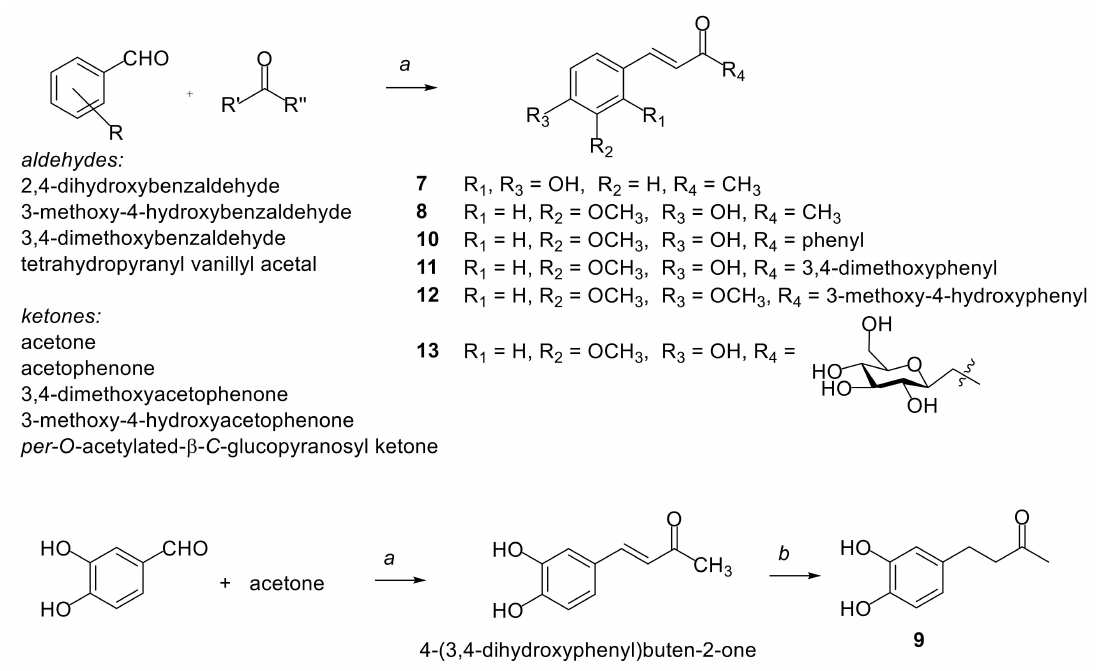
Scheme 1. Reagents and conditions: ( a ) for compound 7 : NaOH , acetone, 12 h at 50 ◦ C ; for compounds